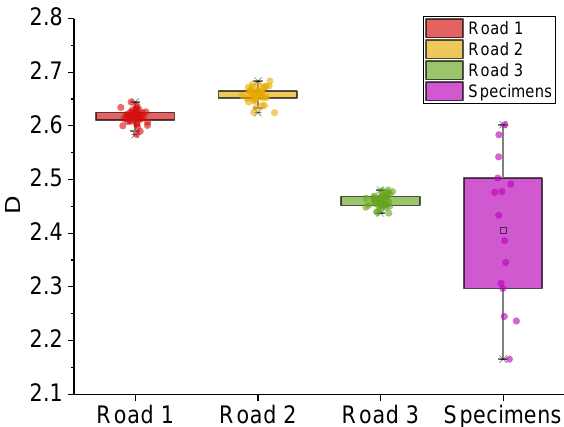
Figure 12. D s of different roads and specimens.